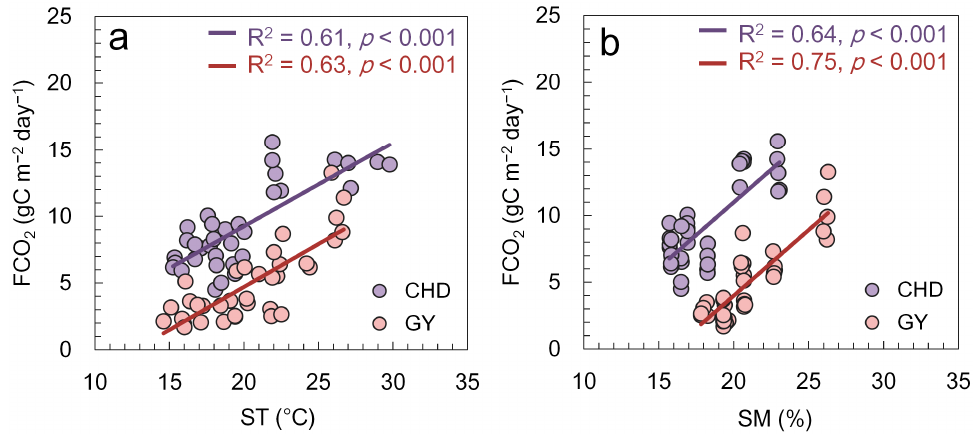
Figure 4. The relationships between the FCO 2 and ( a ) the soil temperature, and ( b ) soil moisture in the CHD ( n = 35) and GY ( n = 35) areas, respectively. Table 3. Pearson correlation coefficients between the FCO 2 ( n = 35) and the different VIs in the CHD and GY area, individually.